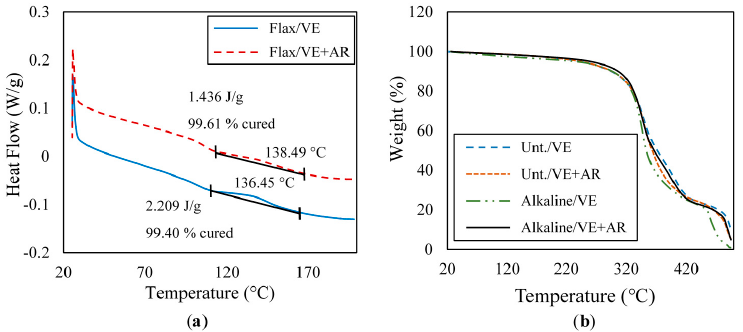
Figure 6. ( a ) Typical DSC trace for heating and cooling of flax/VE and flax/VE+AR; ( b ) typical TGA curves of flax/VE and